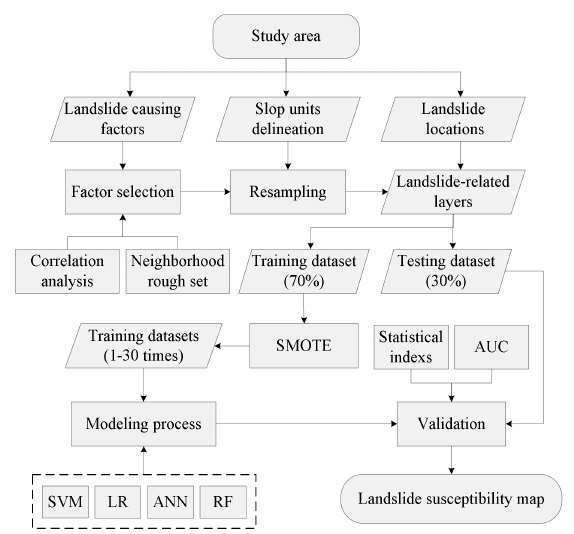
Figure 4. Methodology of the present